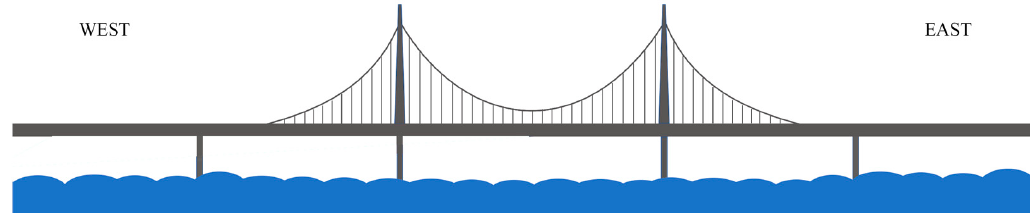
Figure 6. ( a ) Monitoring the bridge vibration by GPRI-II. ( b ) Mounting the GPS receiver on the bridge balustrade. ( c ) The interferometric result acquired at 10:31:07 h.